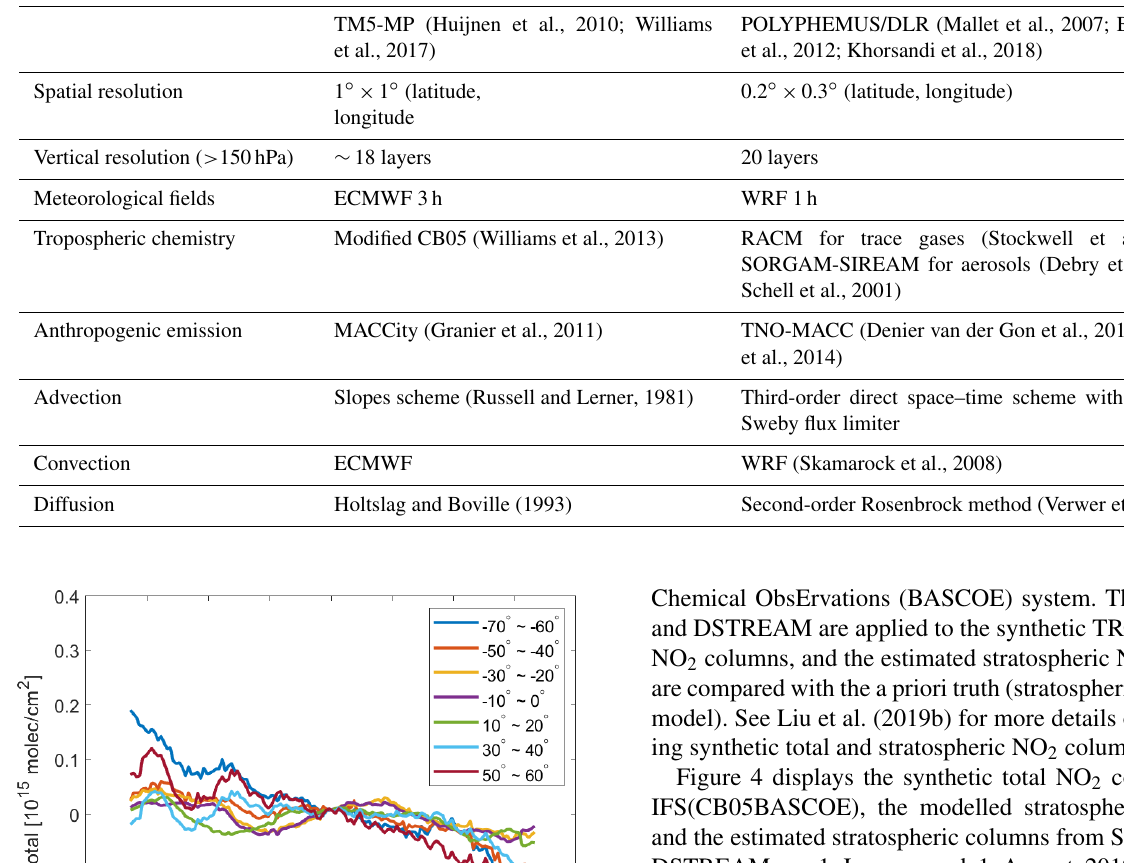
Table 2. Summary of the chemistry transport model specifications.